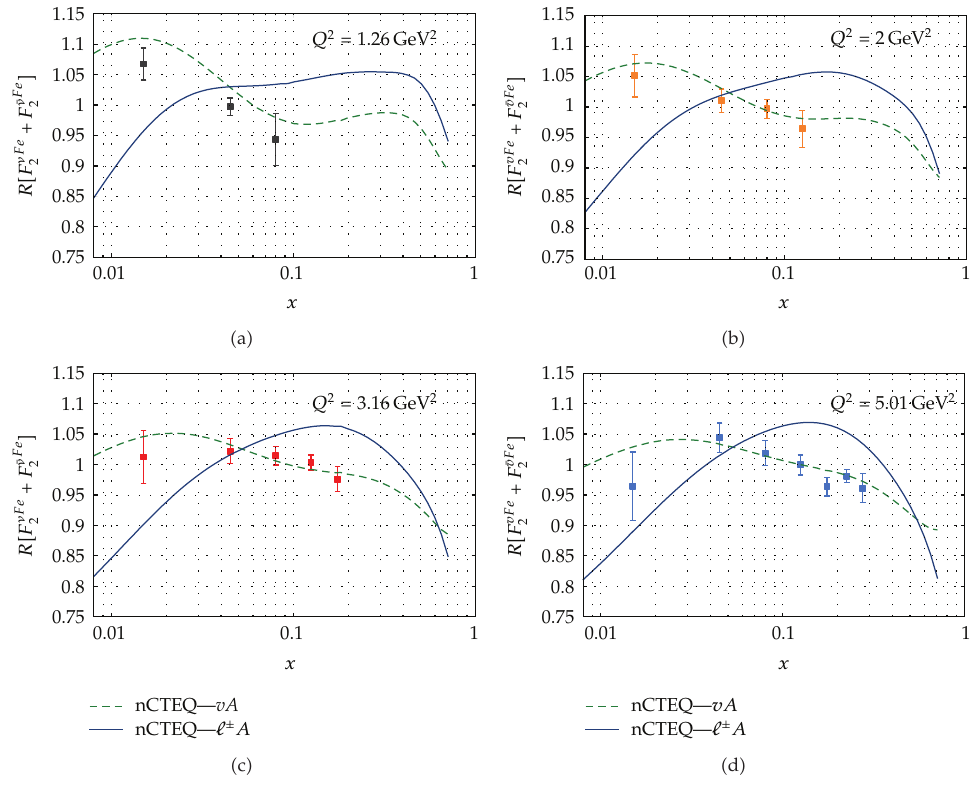
Figure 7: Nuclear correction factor R for the average F 2 structure function in charged current ν Fe scattering at Q 2 (cid:11) 1 . 2 , 2 . 0 , 3 . 2, and 5.0GeV 2 compared to the measured NuTeV points. The green dashed curve shows the result of the nCTEQ analysis of νA (cid:4) CHORUS, CCFR, and NuTeV (cid:5) di ff erential cross sections plotted divided by the results obtained with the reference fit (cid:4) free proton (cid:5) PDFs. For in terms of the average F Fe 2 comparison, the nCTEQ fit to the charged-lepton data is shown by the solid blue